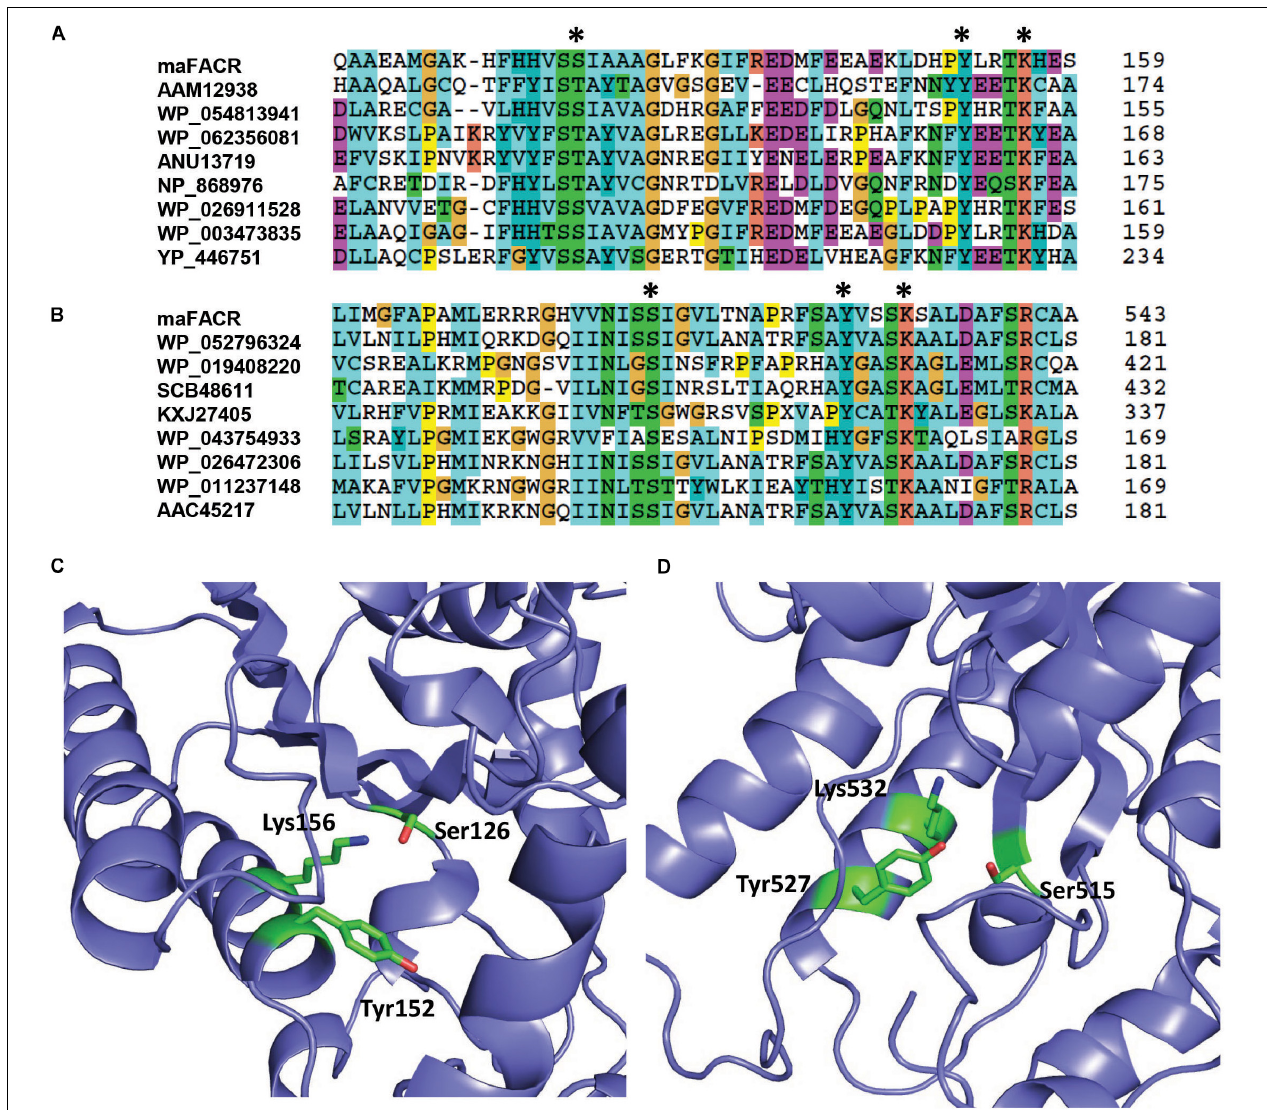
FIGURE 2 | Identification of catalytic residues in maFACR. Alignments of the amino acid sequence of maFACR with proteins from the MupV_like_SDR_e and SDR_c families are shown in (A,B) to identify the catalytic residues (marked *) in the N- and C-terminal domains, respectively. The number on the right for each respective protein indicates the amino acid number of the last residue shown. The identified catalytic residues (in green) of the N- and C-terminal domains in a predicted structure of maFACR are shown in (C,D) ,